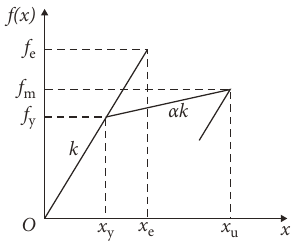
Figure 2: Bilinear elastoplastic